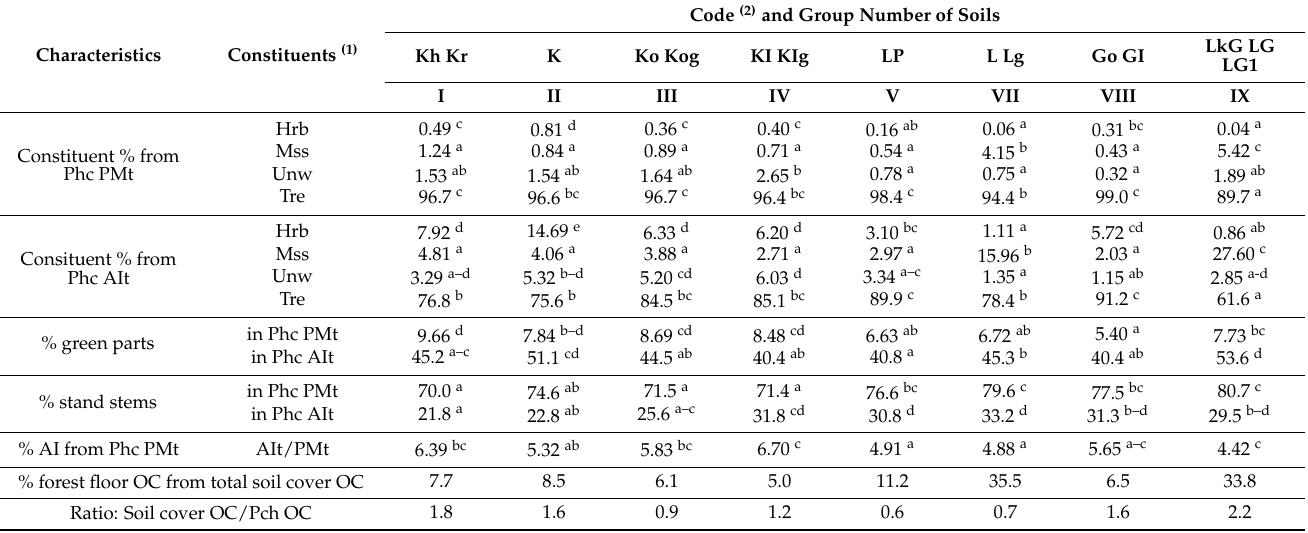
Table 5. The percentage of different constituents of phytocoenoses (Phc) in the total aboveground phytomass and in its annual increases ( n =